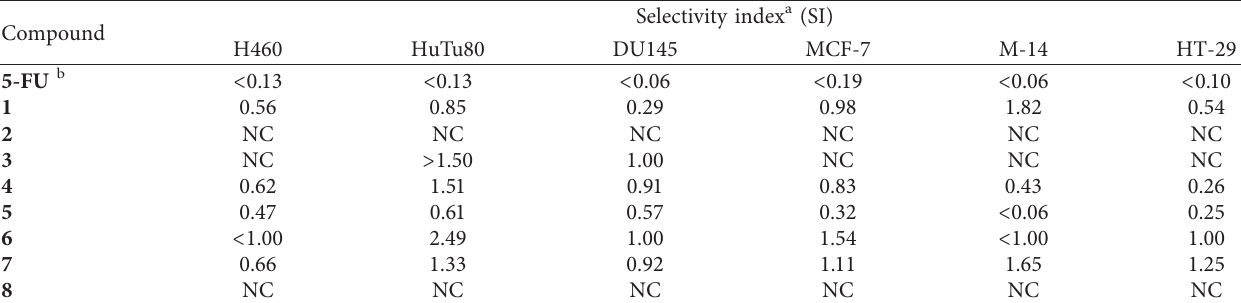
Table 4: Selectivity of the cytotoxicity of the pyridine-3-carbaldehyde thiosemicarbazone derivatives ( 1 – 8 ) to tumor cells, as compared with 3T3 non-tumor